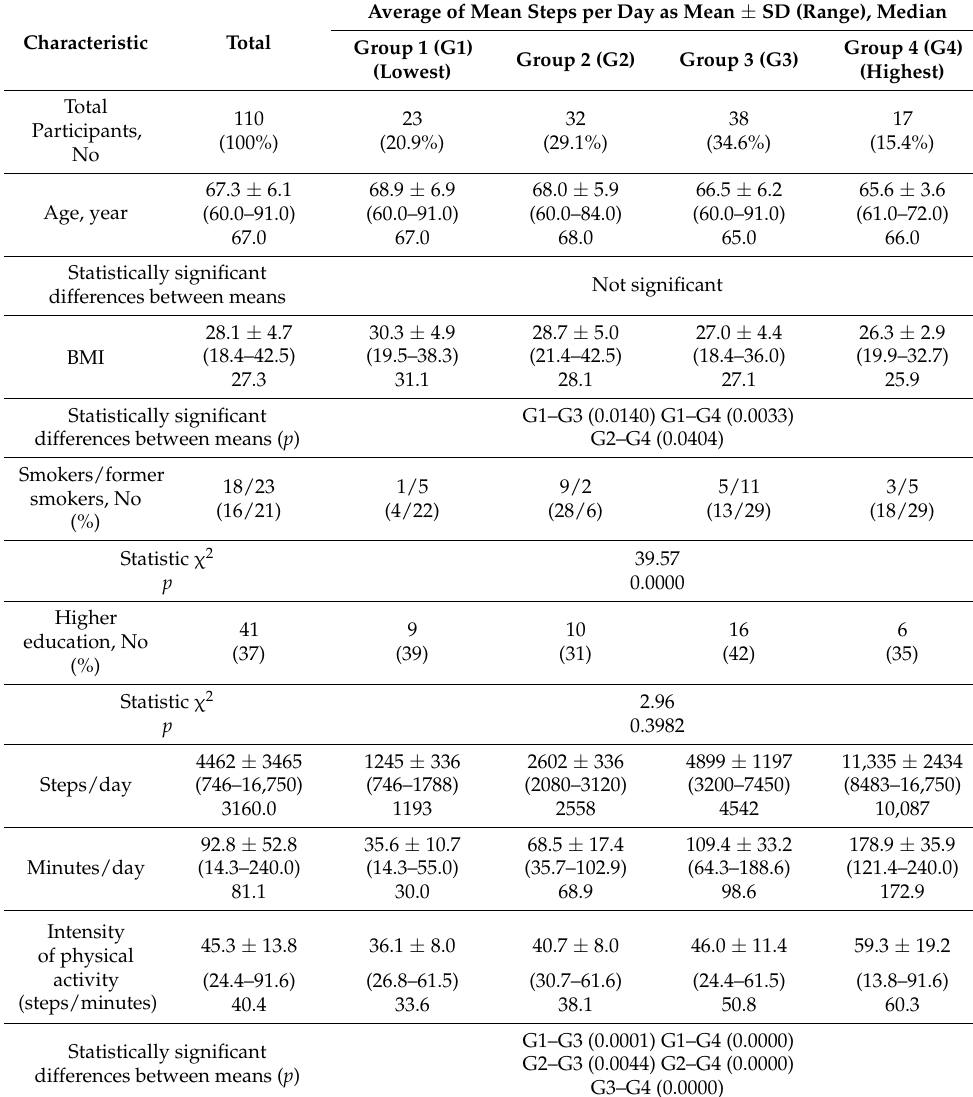
Table 1. Characteristics of the research group and physical activity in the classified